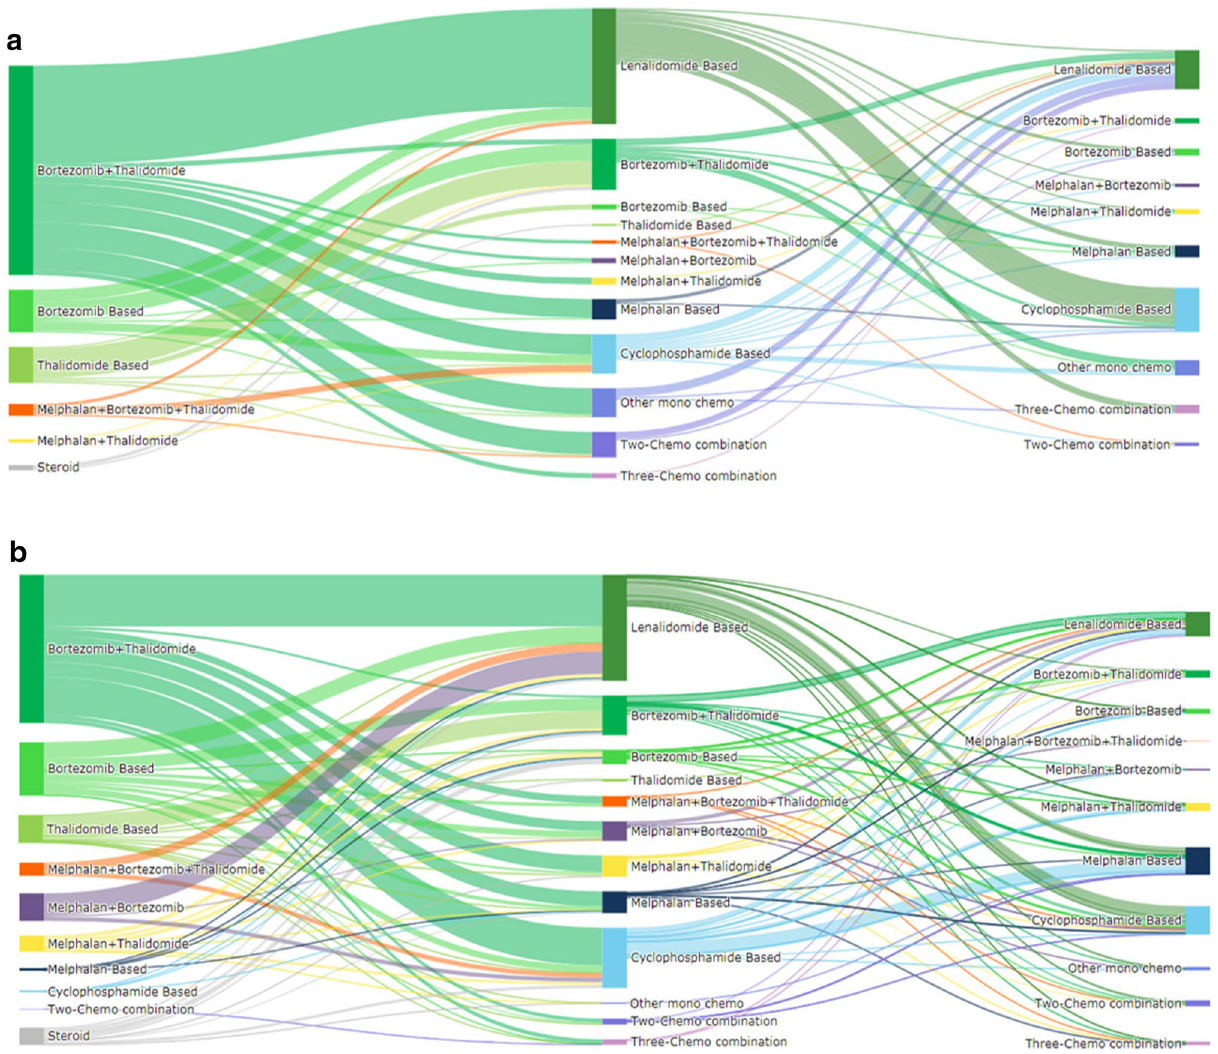
Figure 4. Progression from first to third-line treatment in patients with MM by transplant status in the post-bortezomib period. ( A ) Patients with ASCT. ( B ) Patients without ASCT. ASCT autologous stem cell